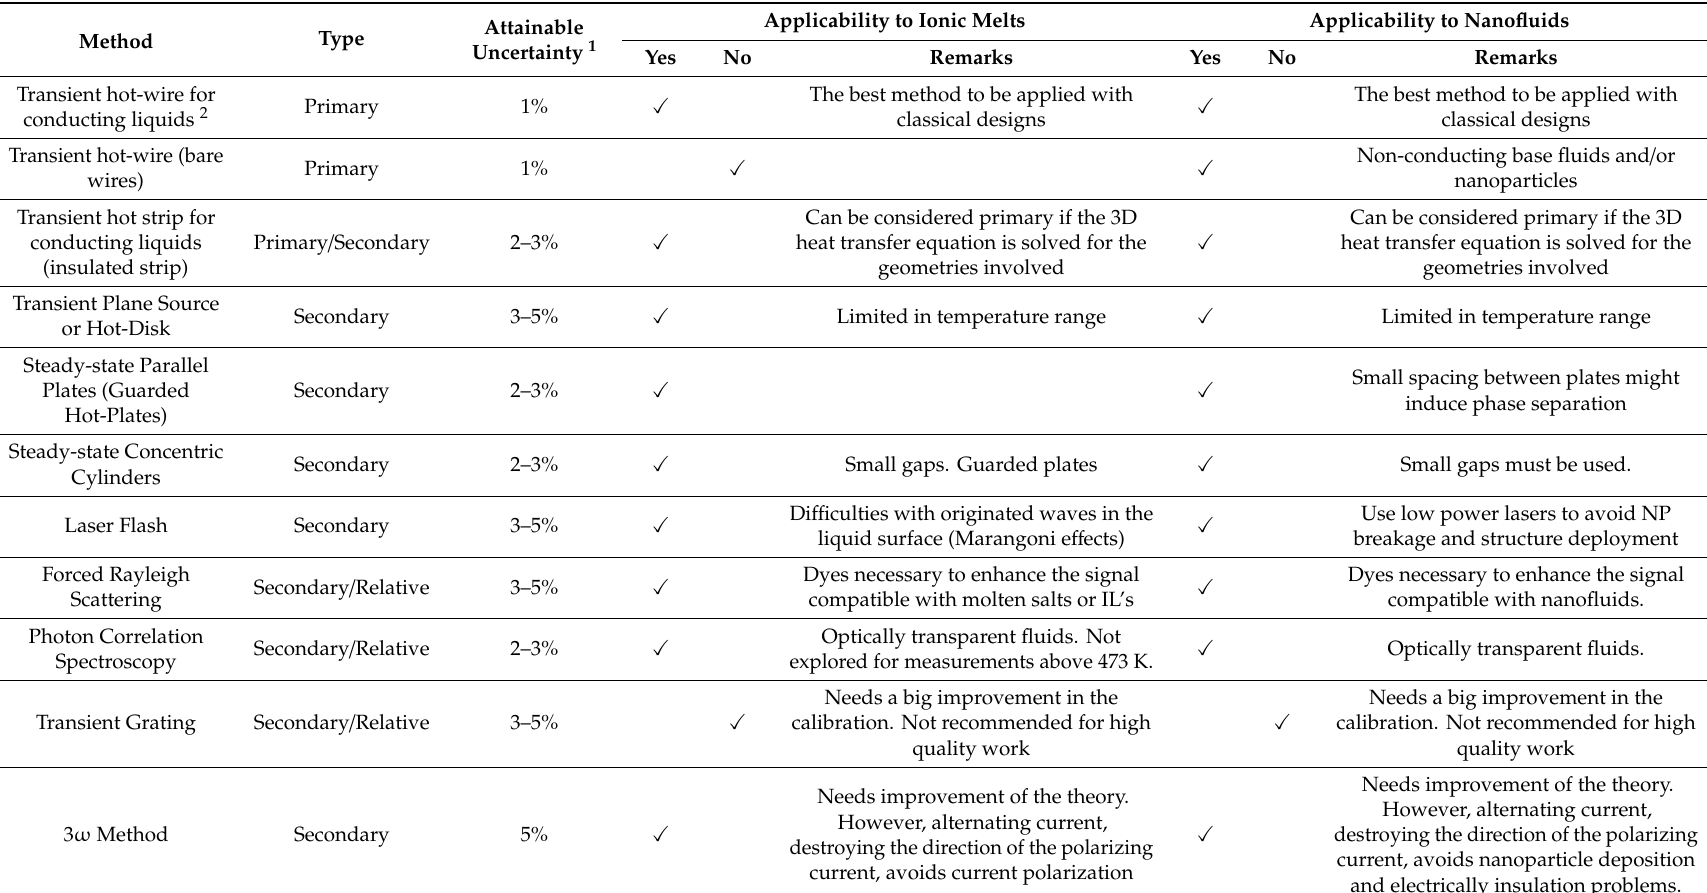
Table 1. Selected methods for the measurement of thermal conductivity (thermal di ff usivity) and its applicability to ionic melts and